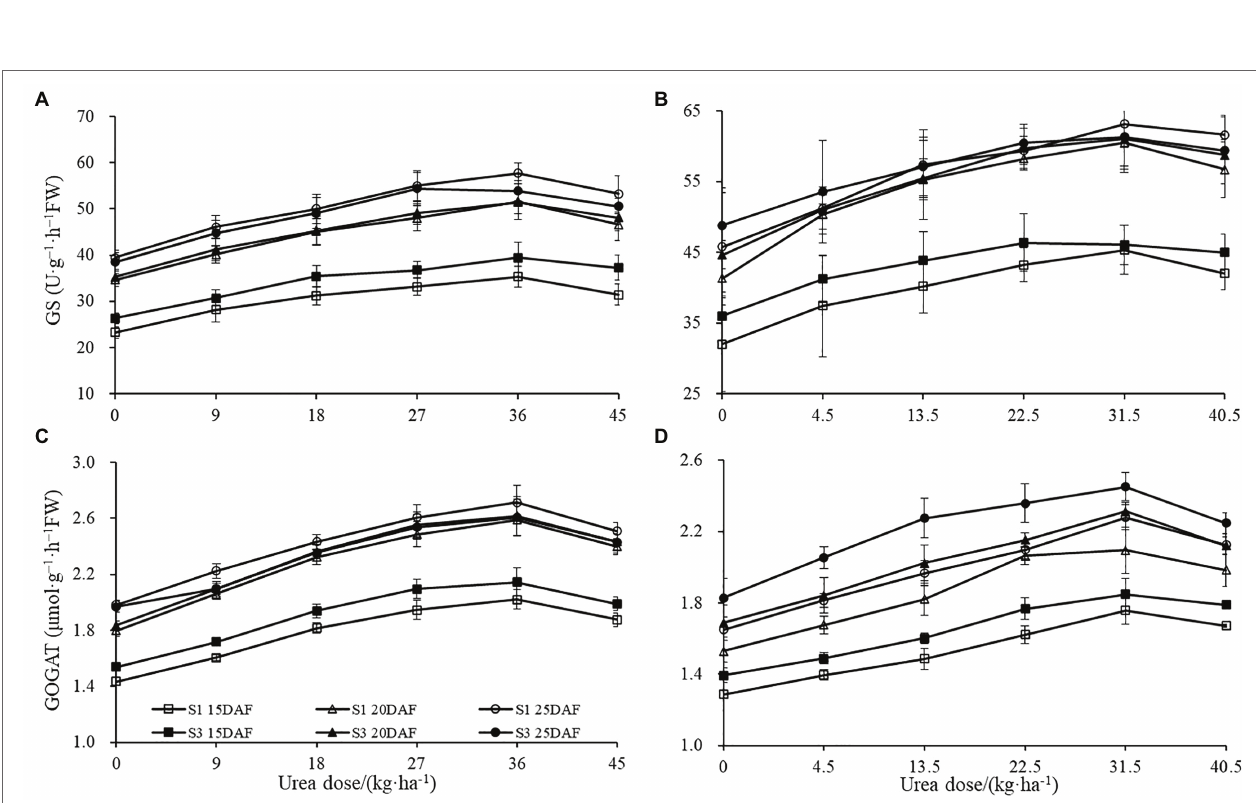
FIGURE 3 | The boll shell amino acid content under different urea doses in 2017 (A) and 2018 (B) . FW represents the fresh weight of the sample, DAF represents the abbreviation of “days after flowering,” and S1 and S3 represent the Sikang 1 and Sikang 3, respectively.